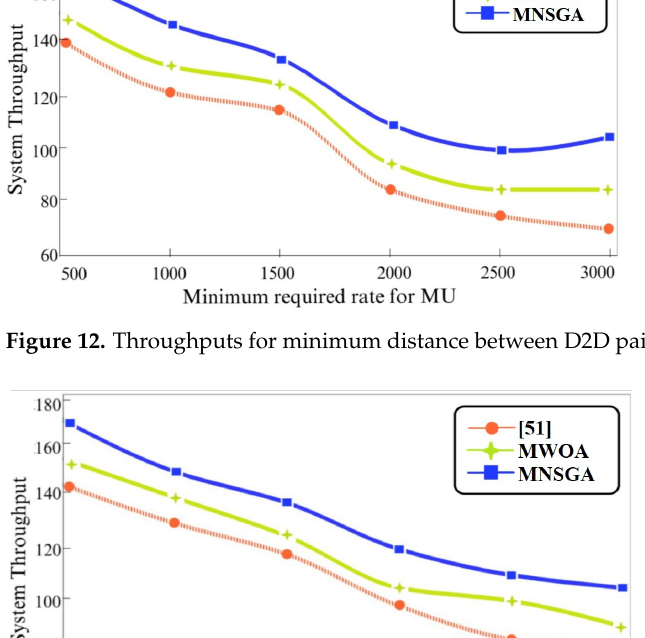
Figure 14. Overall throughputs for minimum distance between D2D pairs. In Figure 14, the system throughput of the MNSGA, MWOA, and [51] algorithms is compared to the overall minimum required rate. MNSGA outperforms both the MWOA and [51] algorithms and MWOA outperforms the algorithm from [51]. In the second experiment, the MNSGA, MWOA, and [51] algorithms are compared in terms of dis- tance between D2D pairs vs. throughput, and MNSGA again performs better than both MWOA and the algorithm from [51]; likewise, MWOA again performs better than the algorithm from [51]. The MNSGA, MWOA, and [51] algorithms are compared again in the third experiment in terms of minimum required rate vs. throughput; MNSGA outperforms both the MWOA and [51] algorithms, and MWOA leaves [51] behind. MNSGA performs well in all categories in terms of number of D2D pairs, distance between D2D pairs, and minimum required rate for MU s, DU s, and overall users. MWAO, on the other hand, outperforms the algorithm from [51] in all scenarios. Both proposed techniques, MNSGA and MWAO, outperformed the algorithm from [51] by producing good results.